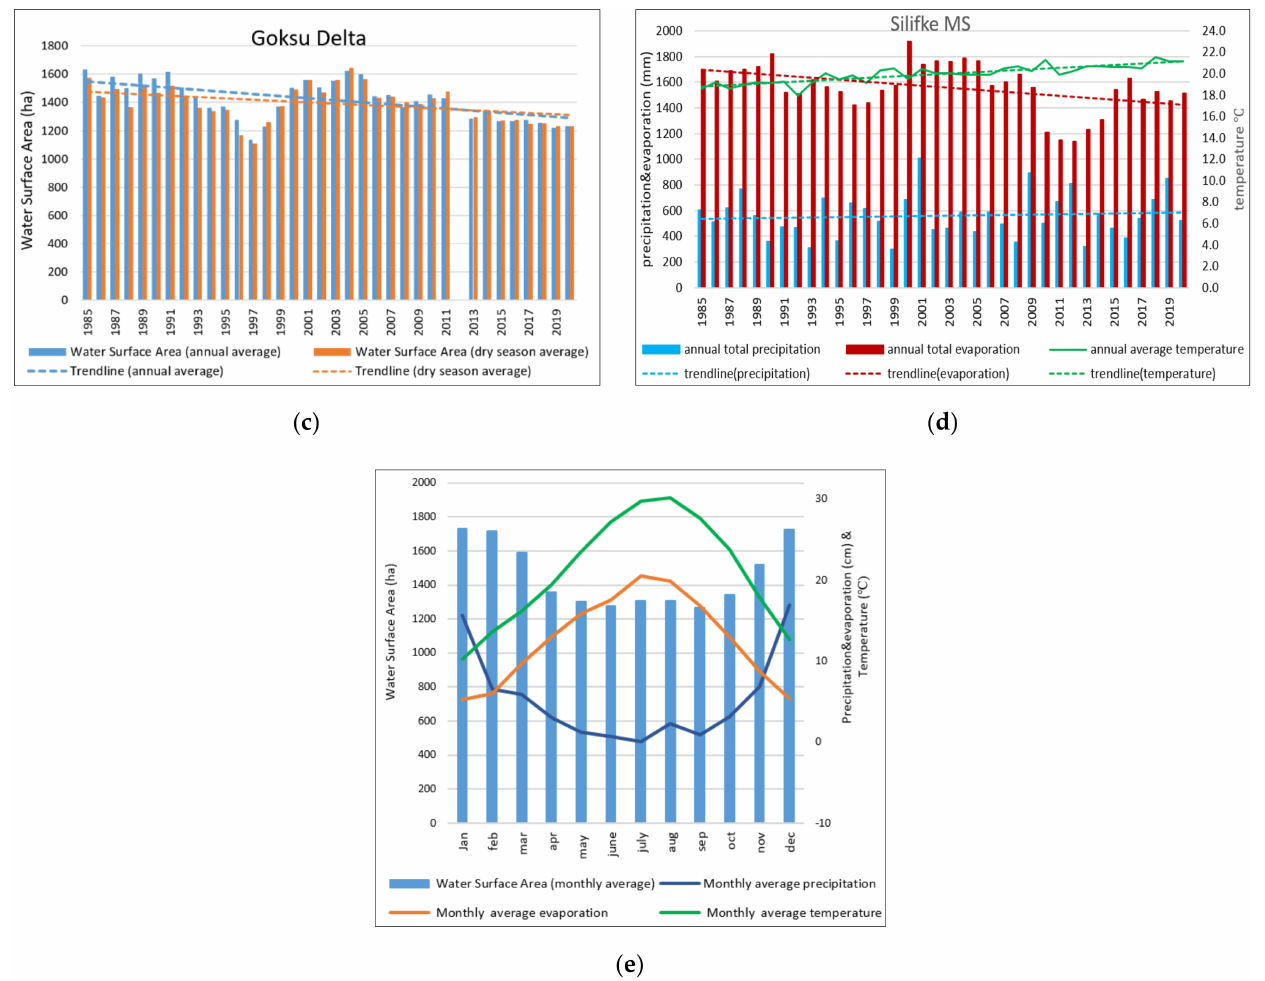
Figure 3. Goksu Delta: ( a ) Location and 1985 and 2020 Annual Average Water Surface Areas (NDWI > 0); ( b ) View of the Goksu Delta [39]; ( c ) 1985-2020 period, Water Surface Areas (Annual Av- erages and Dry Season Averages); ( d ) Silifke Meteorological Station Data (Annual Total Precipitation, Total Evaporation, and Average Air Temperature); ( e ) 2016–2020, Monthly Average Water Surface Areas, Precipitation, Evaporation and